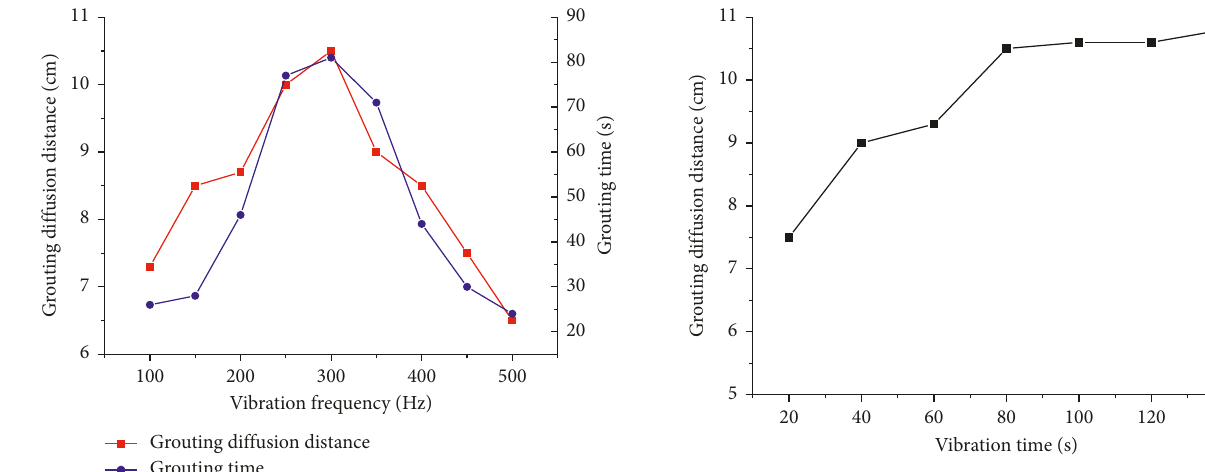
Figure 10: Variation of grout diffusion radius under different vibration